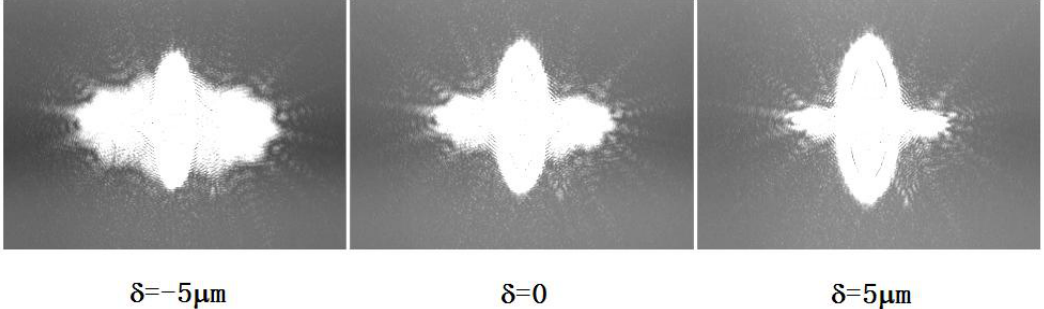
Figure 11. Spot pattern at different defocus